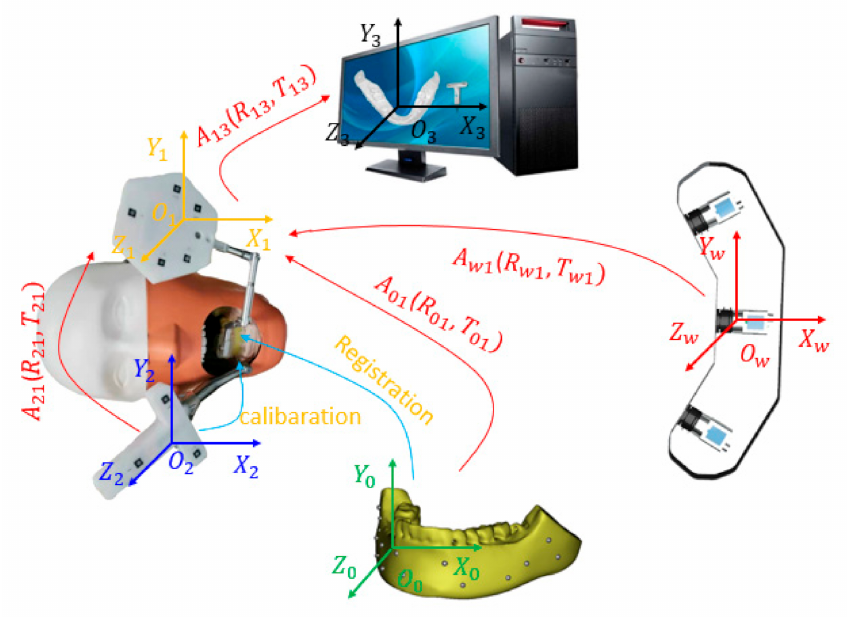
Figure 7. The coordinate transformation of the system, O w is the world coordinate system, O o is the medical image coordinate system, O 1 is the reference coordinate system, O 2 is the drill coordinate system, and O 3 is the screen coordinate